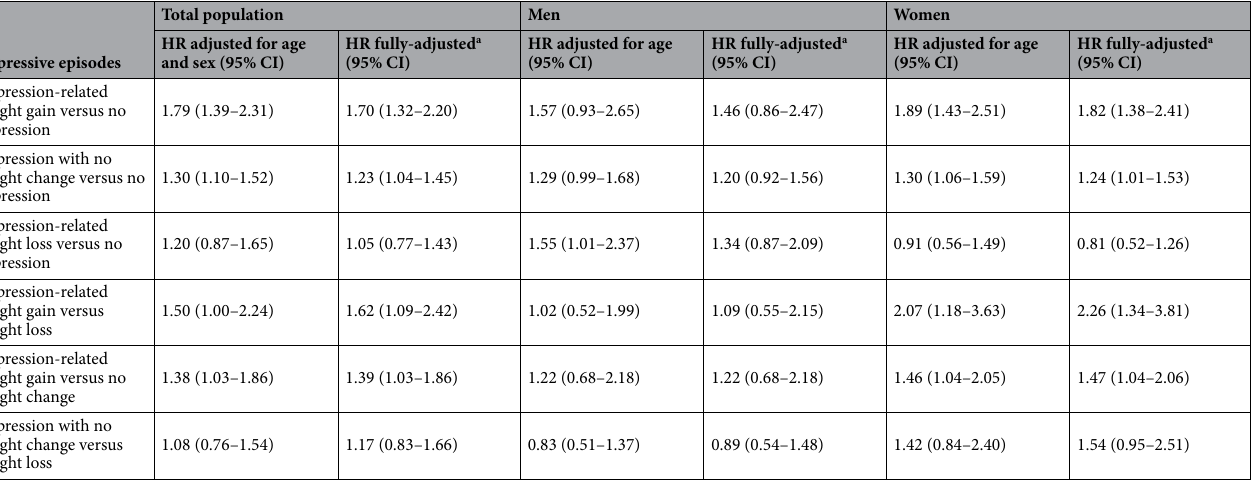
Table 3. Multivariable adjusted hazard models for depression-related weight change and incident type 2 diabetes for Ontario adults in the NPHS 1996, CCHS Cycle 1.1, CCHS Cycle 2.1 (n = 59,315). Weighted using survey weights provided by Statistics Canada; all missing covariates imputed. a Estimates adjusted for age categories, sex, education, income, marital status, geography, born in Canada, ethnicity, smoking, alcohol consumption, physical activity levels, self-reported hypertension and heart disease, and survey